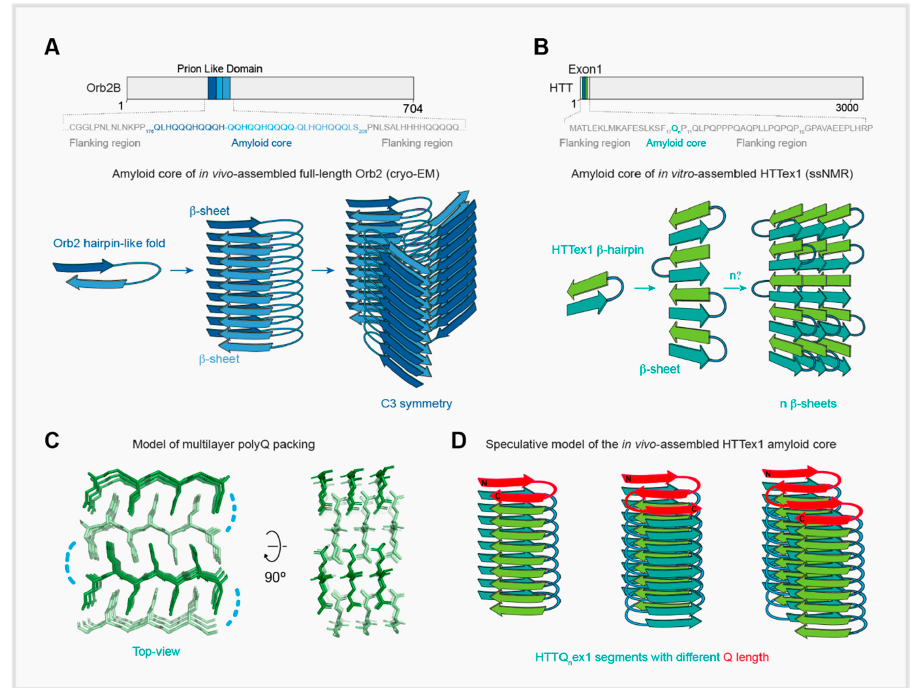
Figure 2. Molecular architecture of Orb2 and Huntingtin amyloids. ( A ) Schematic of the antiparallel hairpin-like fold adopted by head-extracted Orb2 filaments, derived from the cryo-EM structure. Three Orb2 molecules per molecular layer form continuous in-register parallel β -sheets. Different tone of blue represents the different amino acid composition for each β -strand of the hairpin. Amyloid forming sequence is indicated in the top. ( B ) Schematic of the antiparallel β -hairpin adopted by in vitro-assembled HTTex1 amyloid, derived from ssNMR data. One single HTTex1 molecule contributes to two molecular layers to form antiparallel β -sheets. Different tone of green represents the two differently structured β -strand types of the β -hairpin. ( C ) Model of a multilayer packing of the parallel polyQ β -sheets, obtained by extending the Orb2 inter-digitated cross- β structure on both sides. Blue dashed line represents the hairpin turn. The extended glutamine side chains form a steric zipper interface to allow an ~8 Å distance between β -sheets. ( D ) Proposed in vivo HTTex1 filament model based on the multilayer polyQ packing showed in ( C ). Stacks of hairpins or meanders of similar β -strand lengths (highlighted in red), are viewed across the filament axis.